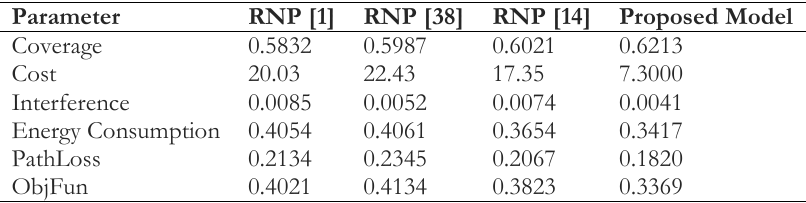
Table 14. Comparison of the proposed RNP model against the existing RNP models, for scenario 1.